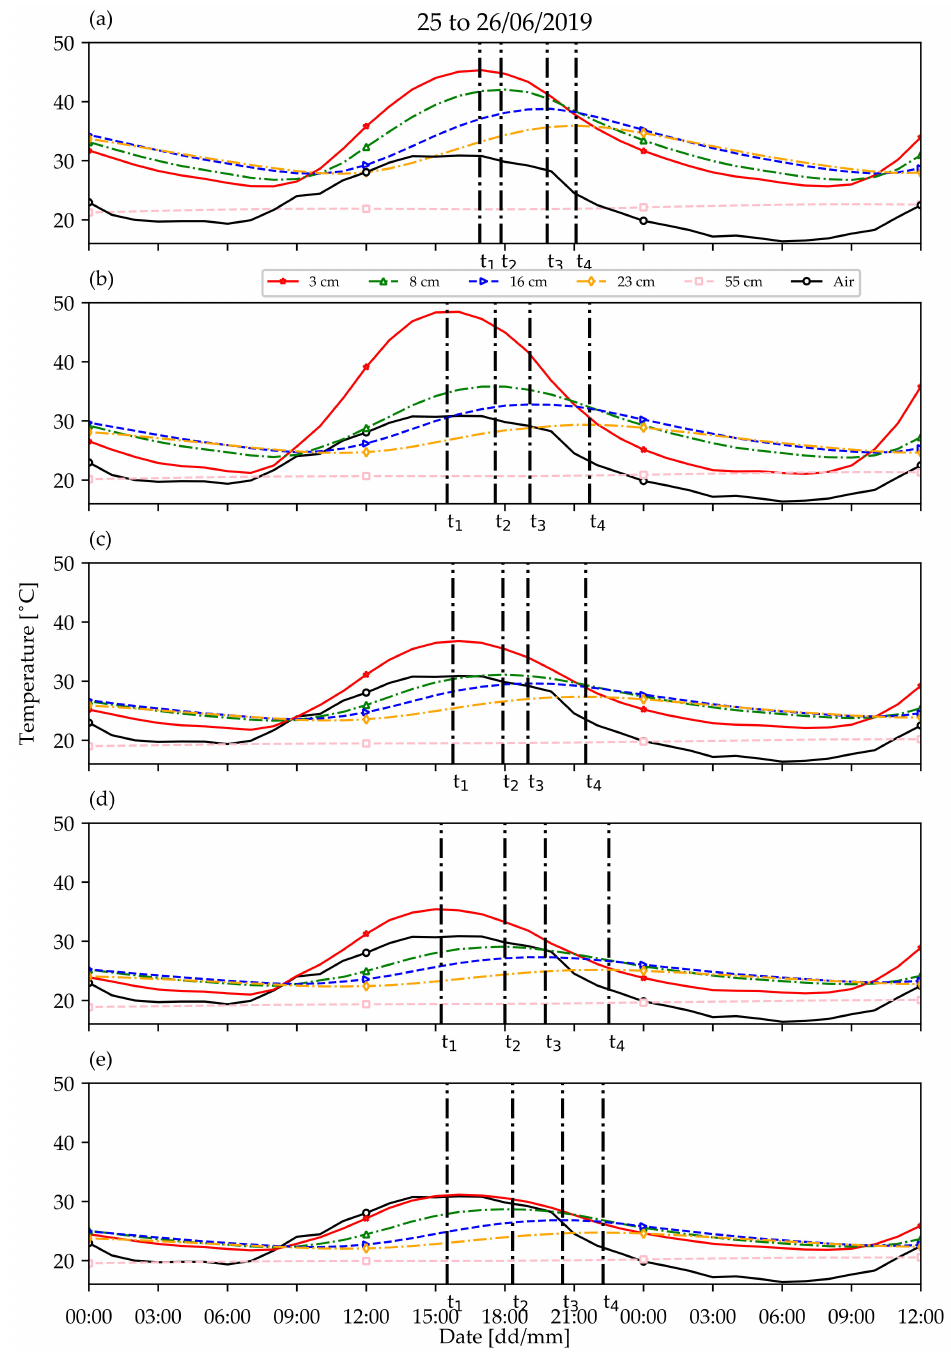
Figure 11. Representation of temperature curves at different depths for P1 ( a ), P3 ( b ), P4 ( c ), P5 ( d ), and CZ9 ( e ) systems from 25 June to 26 June 2019. Temperature at − 3 cm depth is represented with a red solid line with star markers. Temperature at − 8 cm depth is represented with a green dotted line with triangle up markers. Temperature at − 16 cm depth is represented with a blue dotted line with triangle right markers. Temperature at − 24 cm depth is represented with an orange dotted line with diamond markers. Temperature at − 55 cm depth is represented with a pink dashed line with square markers. The black continuous line with round markers represents air ambient temperature. t 1 represents maximum temperature at − 3 cm depth. t 2 represents maximum temperature at − 8 cm depth. t 3 represents maximum temperature at − 16 cm depth. t 4 represents maximum temperature at − 24 cm